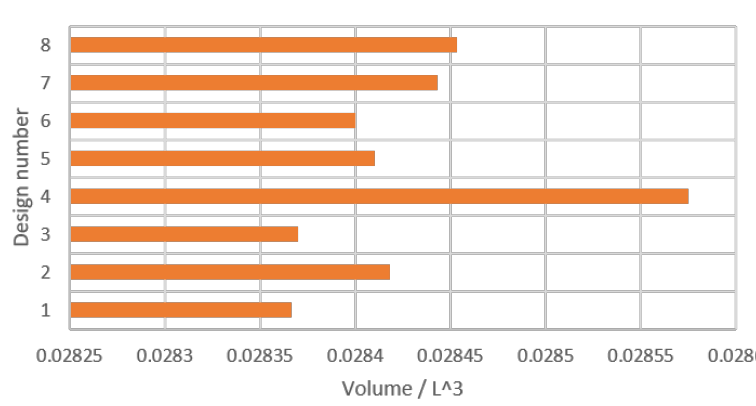
Figure 5. Non-dimensional volume for major